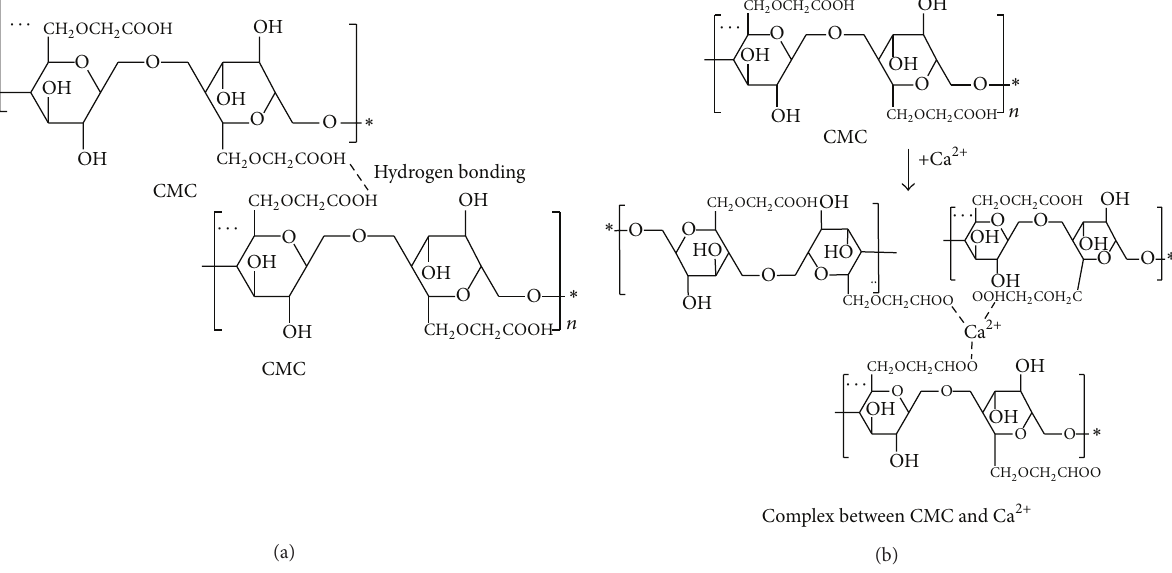
Figure 2: (a) Possible hydrogen bonding between CMC and SA and (b) interaction between Ca 2+ and SA/CMC